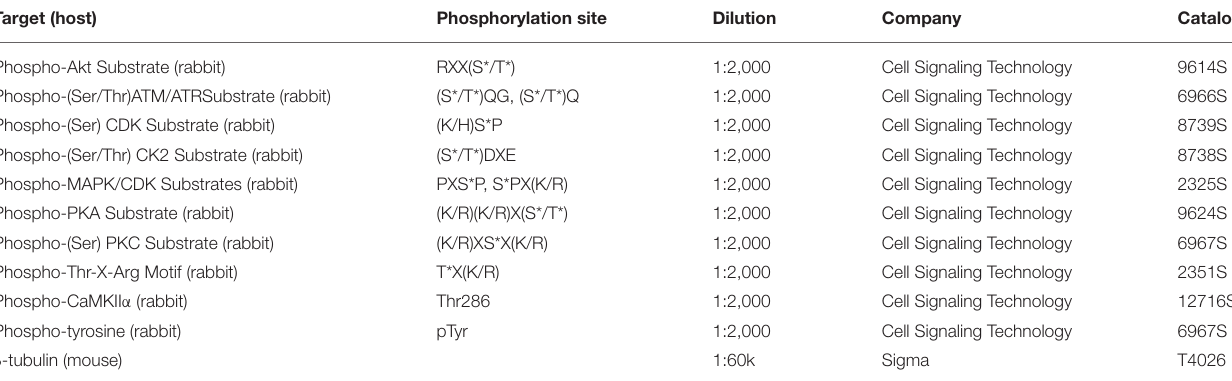
TABLE 1 | List of commercial primary antibodies used for Western blot. Target